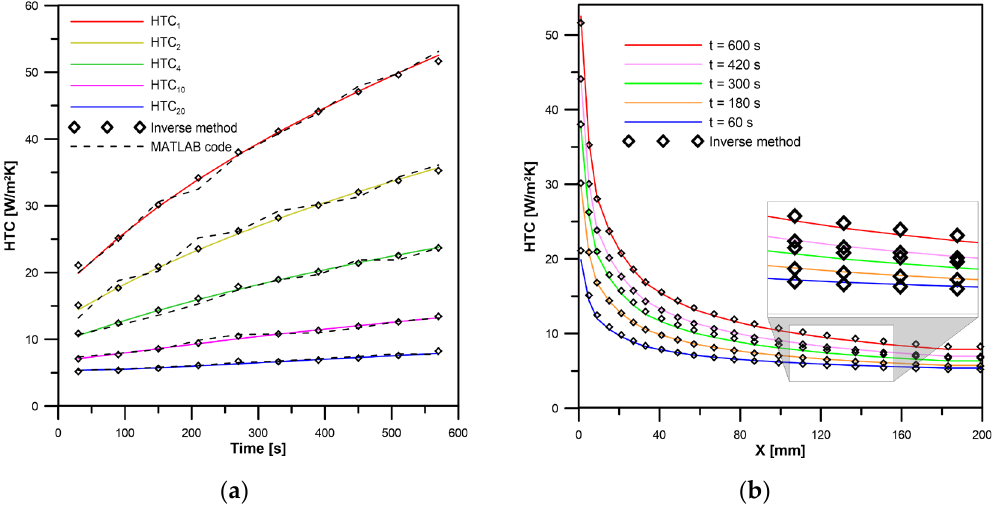
Figure 8. Comparison between exact convective heat transfer coefficients and convective heat transfer coefficients calculated by the inverse method based on “noisy measured data”: ( a ) versus time; ( b ) versus space.